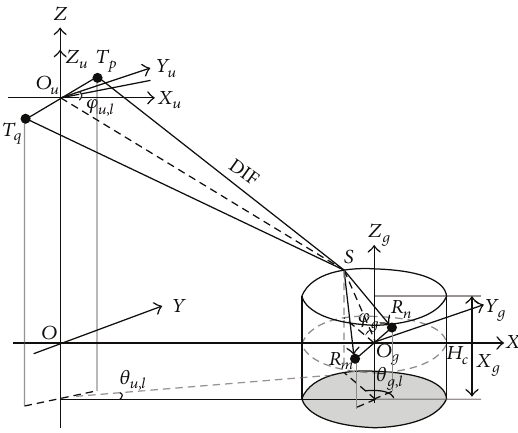
Figure 2: Communication model of DIF